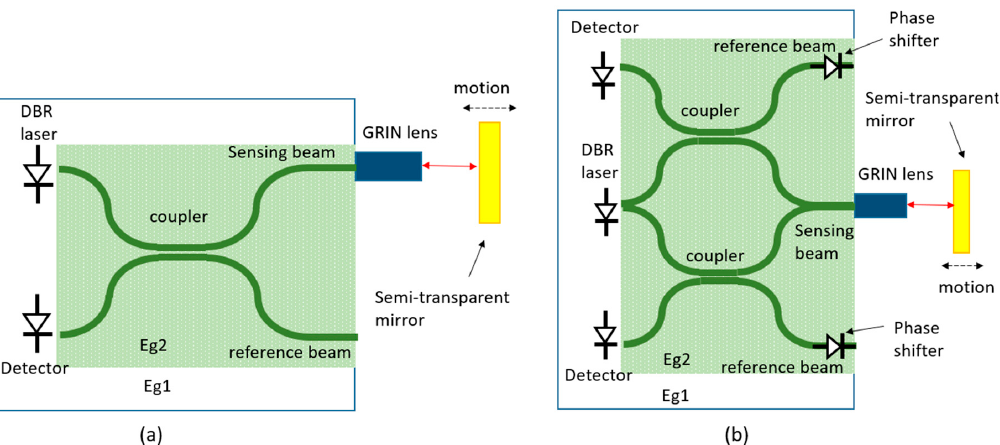
Figure 5. Schematic of integrated interferometers demonstrated on GaAs/AlGaAs. ( a ) A single Michelson interferometer and ( b ) a double Michelson interferometer. Different types of vibrometers have been demonstrated on the SOI platform. An SOI- based homodyne LDV configuration with general purposes has been demonstrated [34] (Figure 6). In this device, a 1550 nm light signal from an external laser source is coupled to the SOI-PIC via a single-mode fiber and a grating coupler. In PIC, the light signal is split into a measurement signal and a reference signal by a 1 × 2 multi-mode interference (MMI) coupler. The measurement signal is coupled out of the PIC to free space via a trans- mitting grating coupler. After the measurement signal is reflected from a target, a receiv- ing grating coupler couples the reflected light to PIC. The layout of the transmitting and receiving grating couplers ensures that the centers of both grating couplers are close to each other. The reflected measurement light is combined with the reference signal in a 2 × 4 MMI coupler, which works as a 90-degree hybrid [87]. These four optical signals are then sent out of the PIC via four fibers to two external balanced-PDs. Finally, two quad- rature signals (I and Q) are obtained. A fiber array with five ports is connected to the grating couplers in PIC to transport light from the laser sources to the PIC and from the PIC to the PDs. The footprint of the device is around 0.5 mm × 2.5 mm. This footprint is not optimized, because the fiber array reserves a big area of the PIC. If the light beam can be coupled out of the PIC from the bottom side of the PIC, the footprint of the design can be even reduced. The reported displacement resolution of this LDV at 31 Hz is around 6 nm.